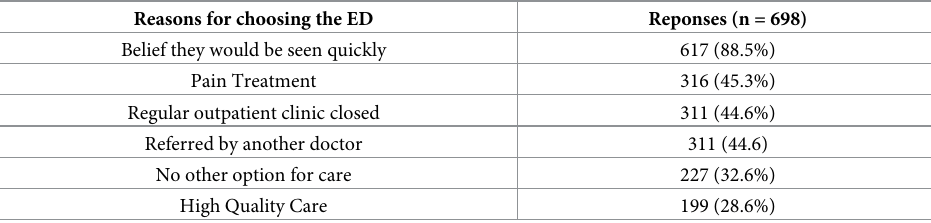
Table 5. Reasons for choosing the